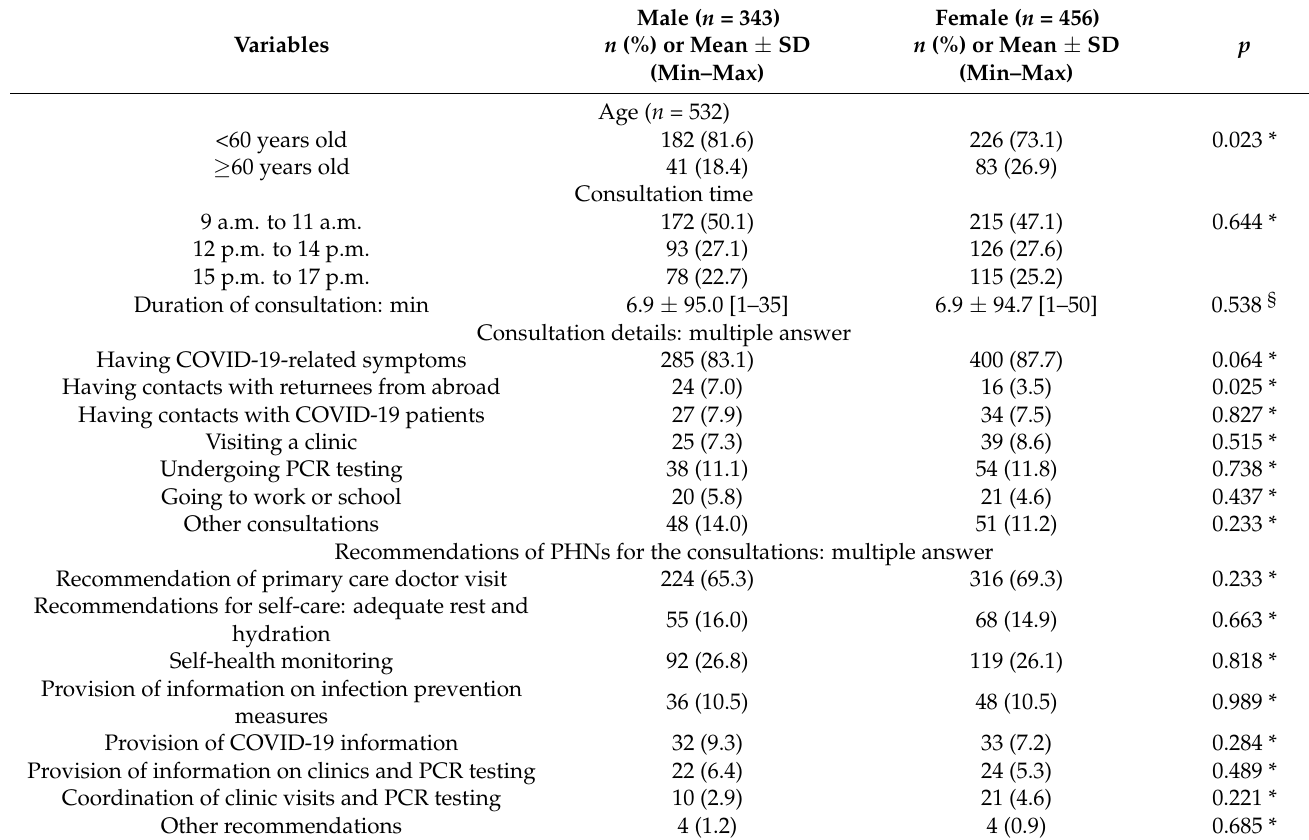
Table 2. Characteristics of consultations by the sex differences in the resident group ( N =